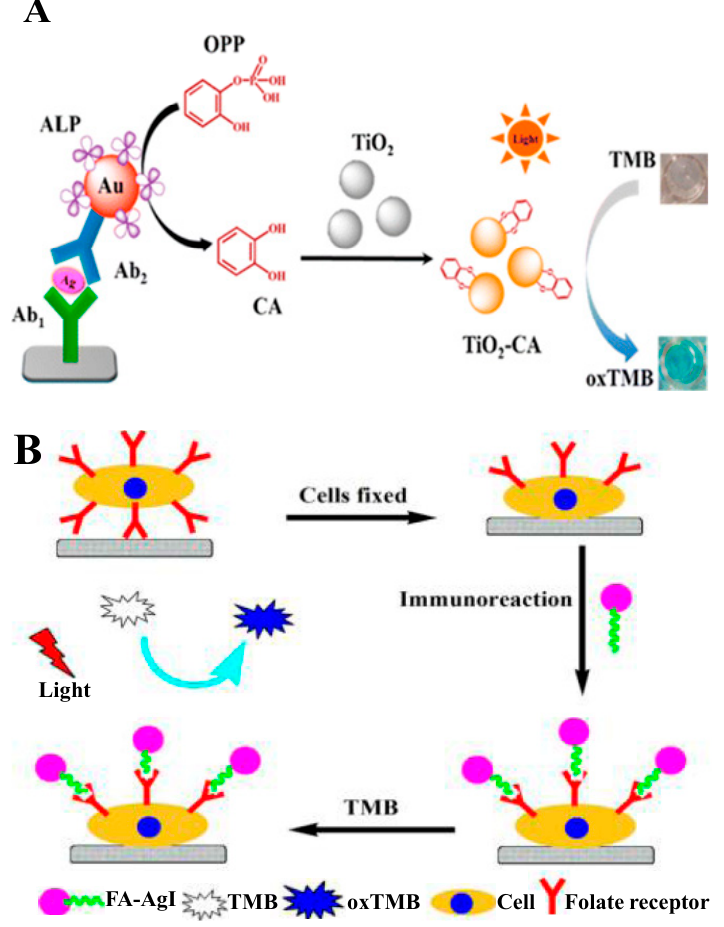
Figure 7. ( A ) Proposed immunodetection process for mouse IgG by coupling the cascade reaction of alkaline phosphatase (ALP) and the enzymatically in situ generated photoresponsive nanozyme of TiO 2 -CA. Reproduced with permission from [80]. Copyright American Chemical Society, 2017. ( B